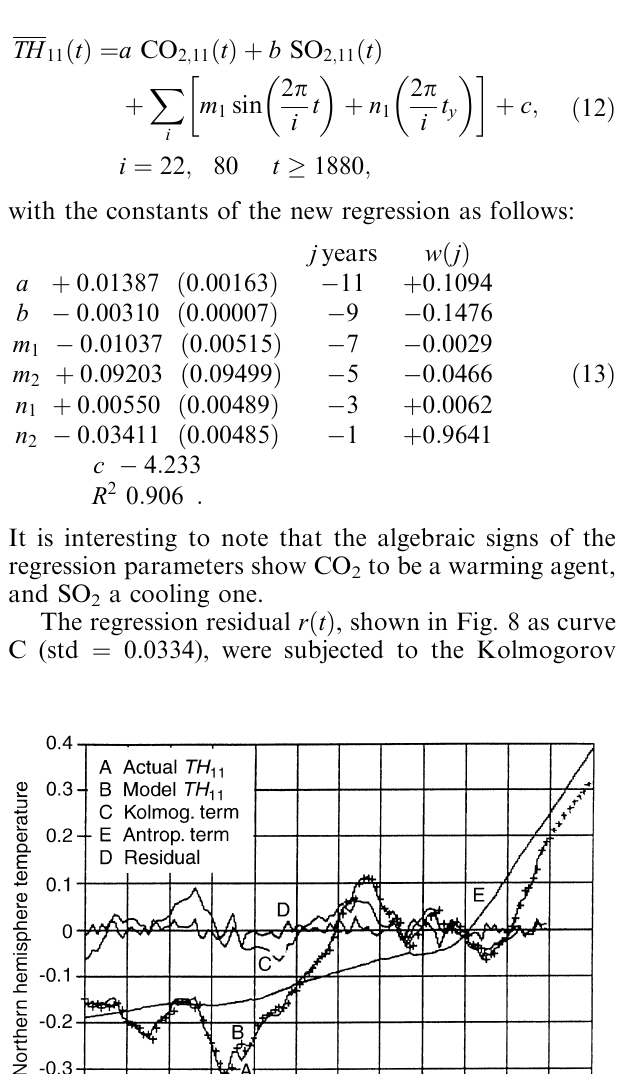
Fig. 7. Northern hemisphere temperature anomaly